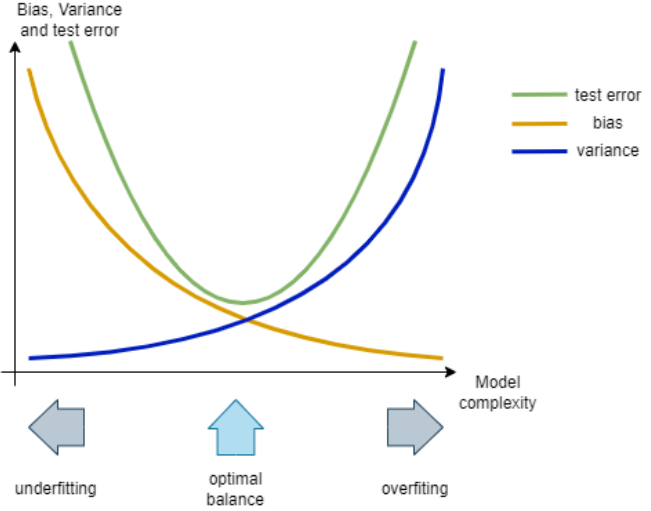
Figure 5. The bias–variance tradeoff